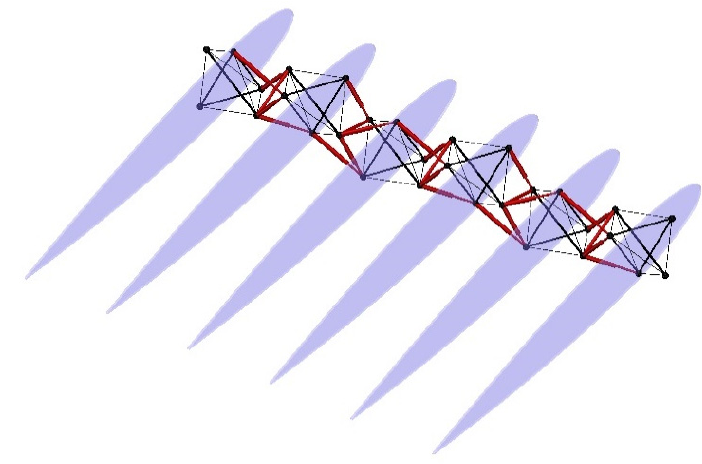
Figure 7. Three-dimensional figure of the morphing wing.